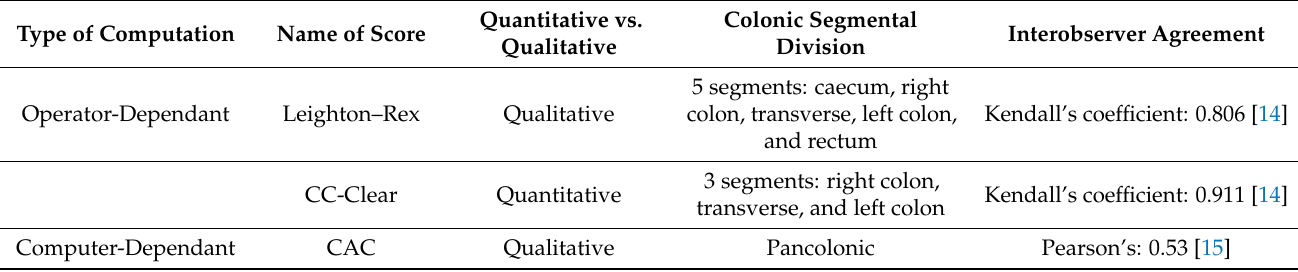
Table 6. Summary of bowel cleanliness scores.